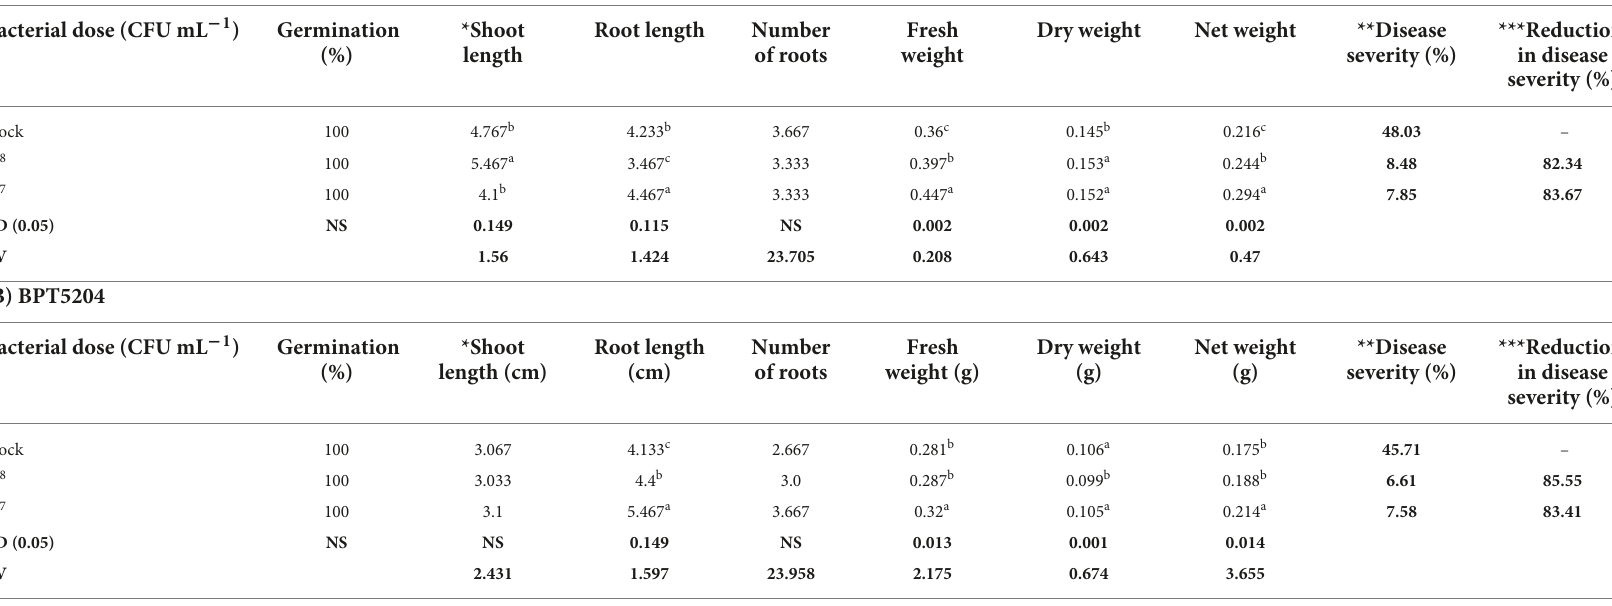
TABLE 2 Growth stimulant and blast suppressive activity of Microbacterium testaceum D18 on rice. (A) Pusa Basmati-1